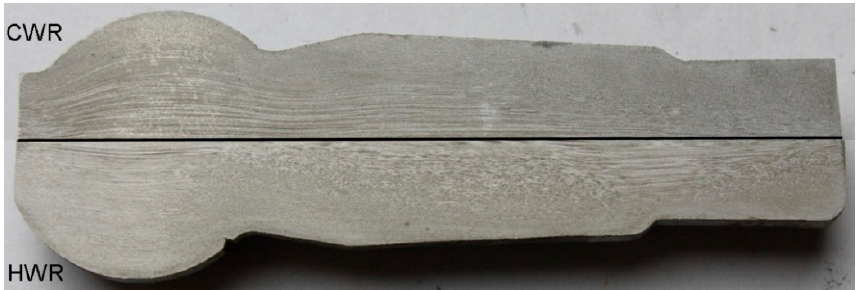
Figure 13. Material flow lines observed after etching in Jacewicz’s reagent (38 cm 3 HCL + 12 cm 3 H 2 SO 4 (1.83 g/cm 3 ) + 50 cm 3 H 2 O).